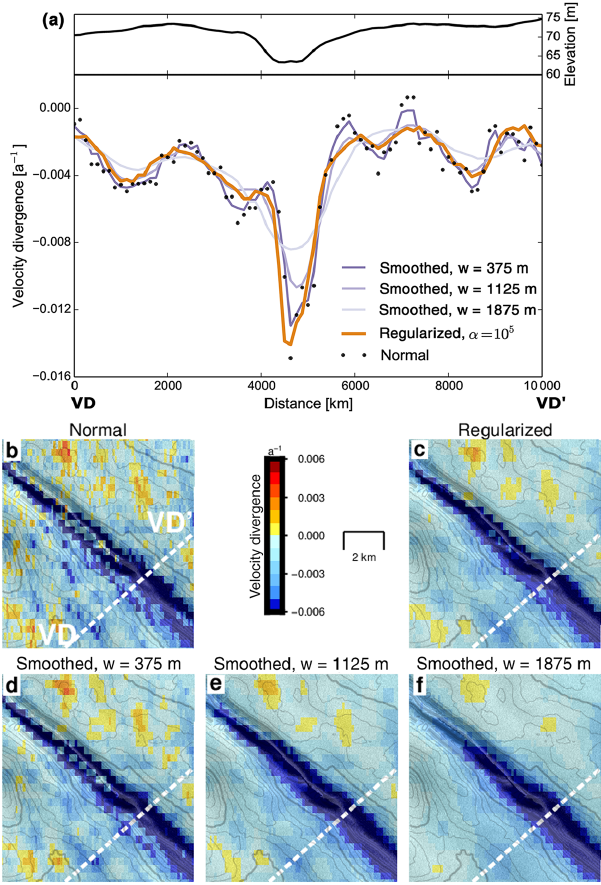
Figure 3. Velocity divergence at an ice shelf channel located in Fig 4. (a) Profile showing elevation and velocity divergence for var- ious degree of smoothing (w = window width) and after regulariza- tion ( α = 10 5 ). (b–f) Corresponding spatial pattern of the velocity- divergence profiles shown in panel (a) . The background image is from Landsat 8, acquired in 2014 and the maps are overlain with elevation contour lines of